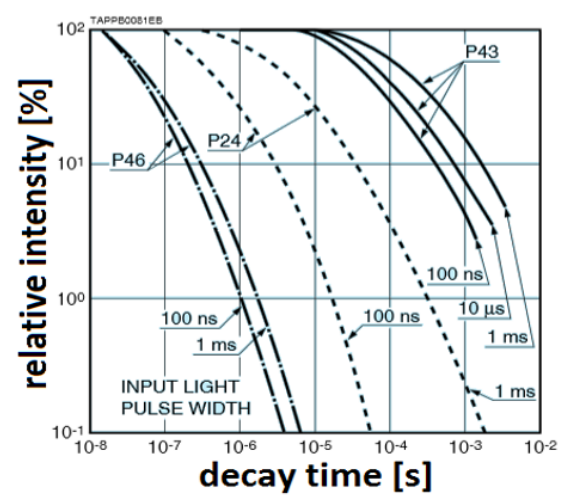
Fig. 3. Phosphor screen decay characteristics for different types of luminophores . [7]